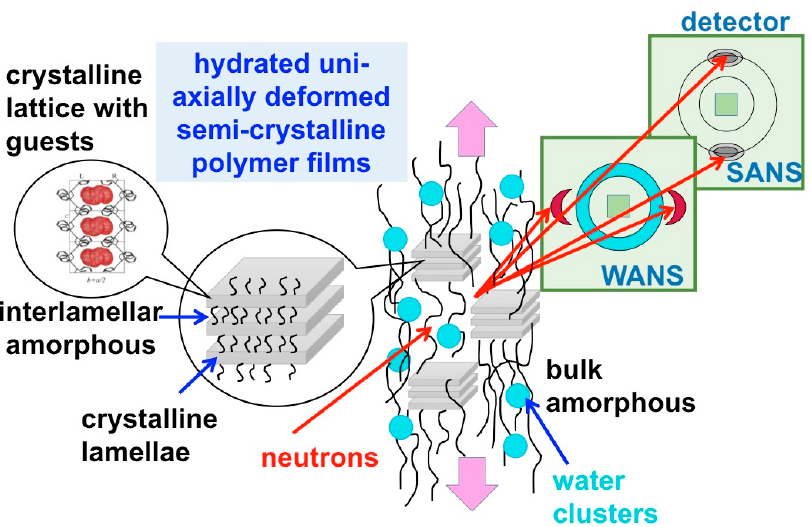
Figure 1. Schematic view of the experimental approach used in this study: the uniaxially polymer film deformation is indicated by the pink arrows, while the morphologies occurring at different length scales, which are shown in the left side of the scheme, yield on the two-dimensional small-angle neutron scattering (SANS) detector scattering features that appear at different scattering angles, either in the wide-angle (WANS) or small-angle (SANS) regime, as isotropic or localized details.